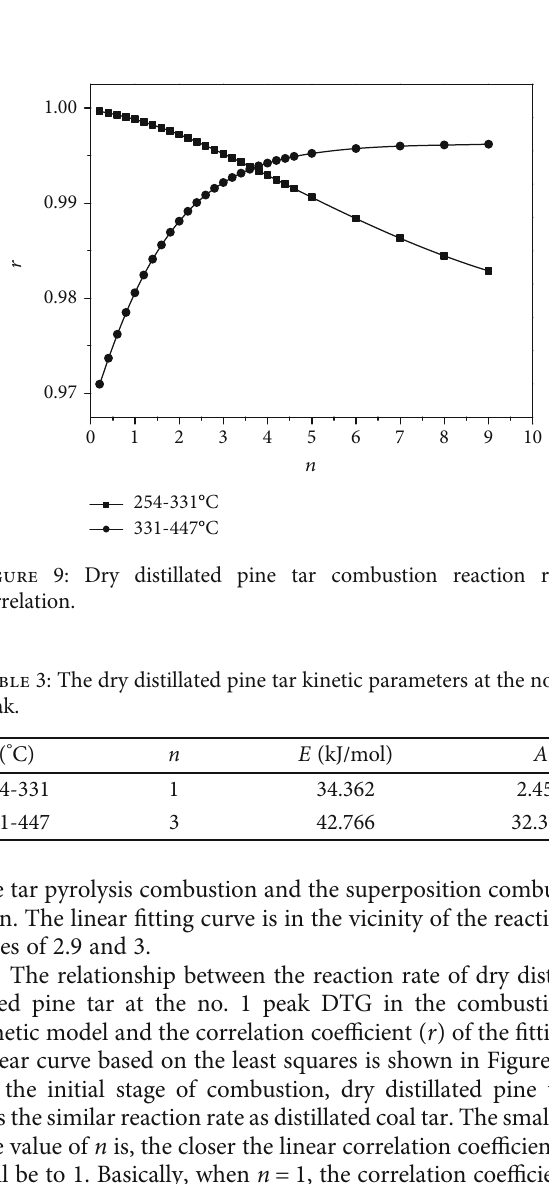
Figure 8: Pine tar combustion kinetic characteristics at 331-447 ° C.